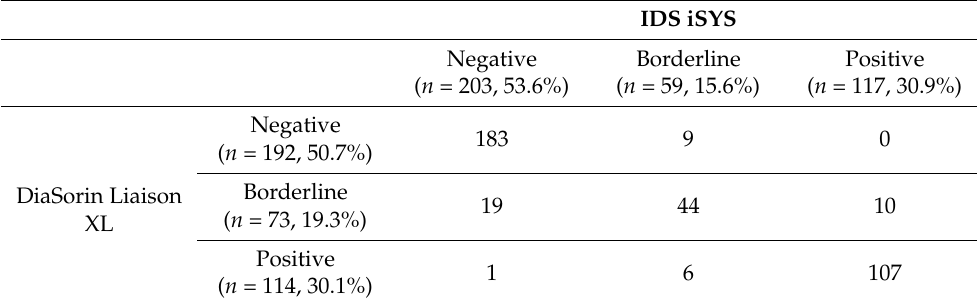
Table 3. Classification of patients according to the recommended 50–250 µ g/g cut-offs. IDS iSYS Negative Borderline Positive ( n = 203, 53.6%) ( n = 98, 25.9%) ( n = 78, 20.6%) Negative 183 8 0 ( n = 190, 50.4%) Borderline DiaSorin Liaison 20 82 10 ( n = 112, 29.6%) XL Positive 0 ( n = 76, 20.1%)